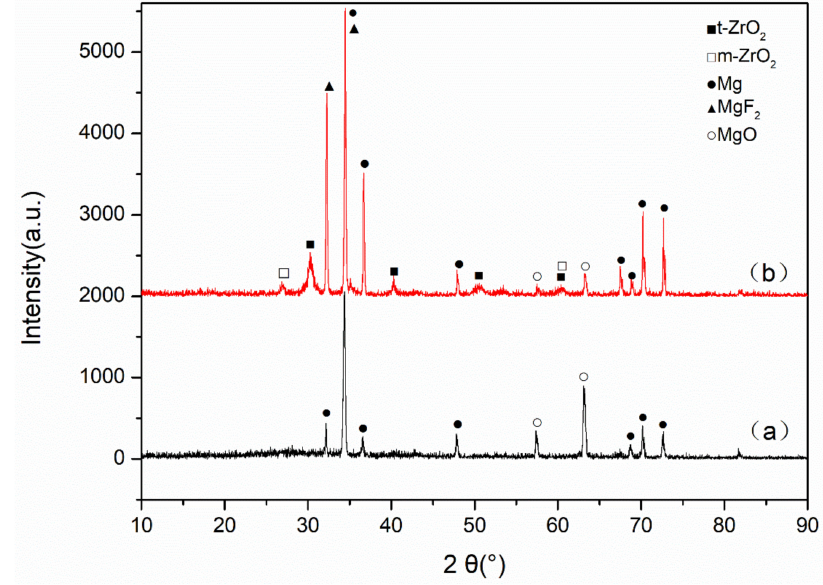
Figure 1. X-ray diffraction (XRD) patterns of PEO coatings on AZ31 Mg alloy: ( a ) MgO coating, and ( b ) ZrO 2